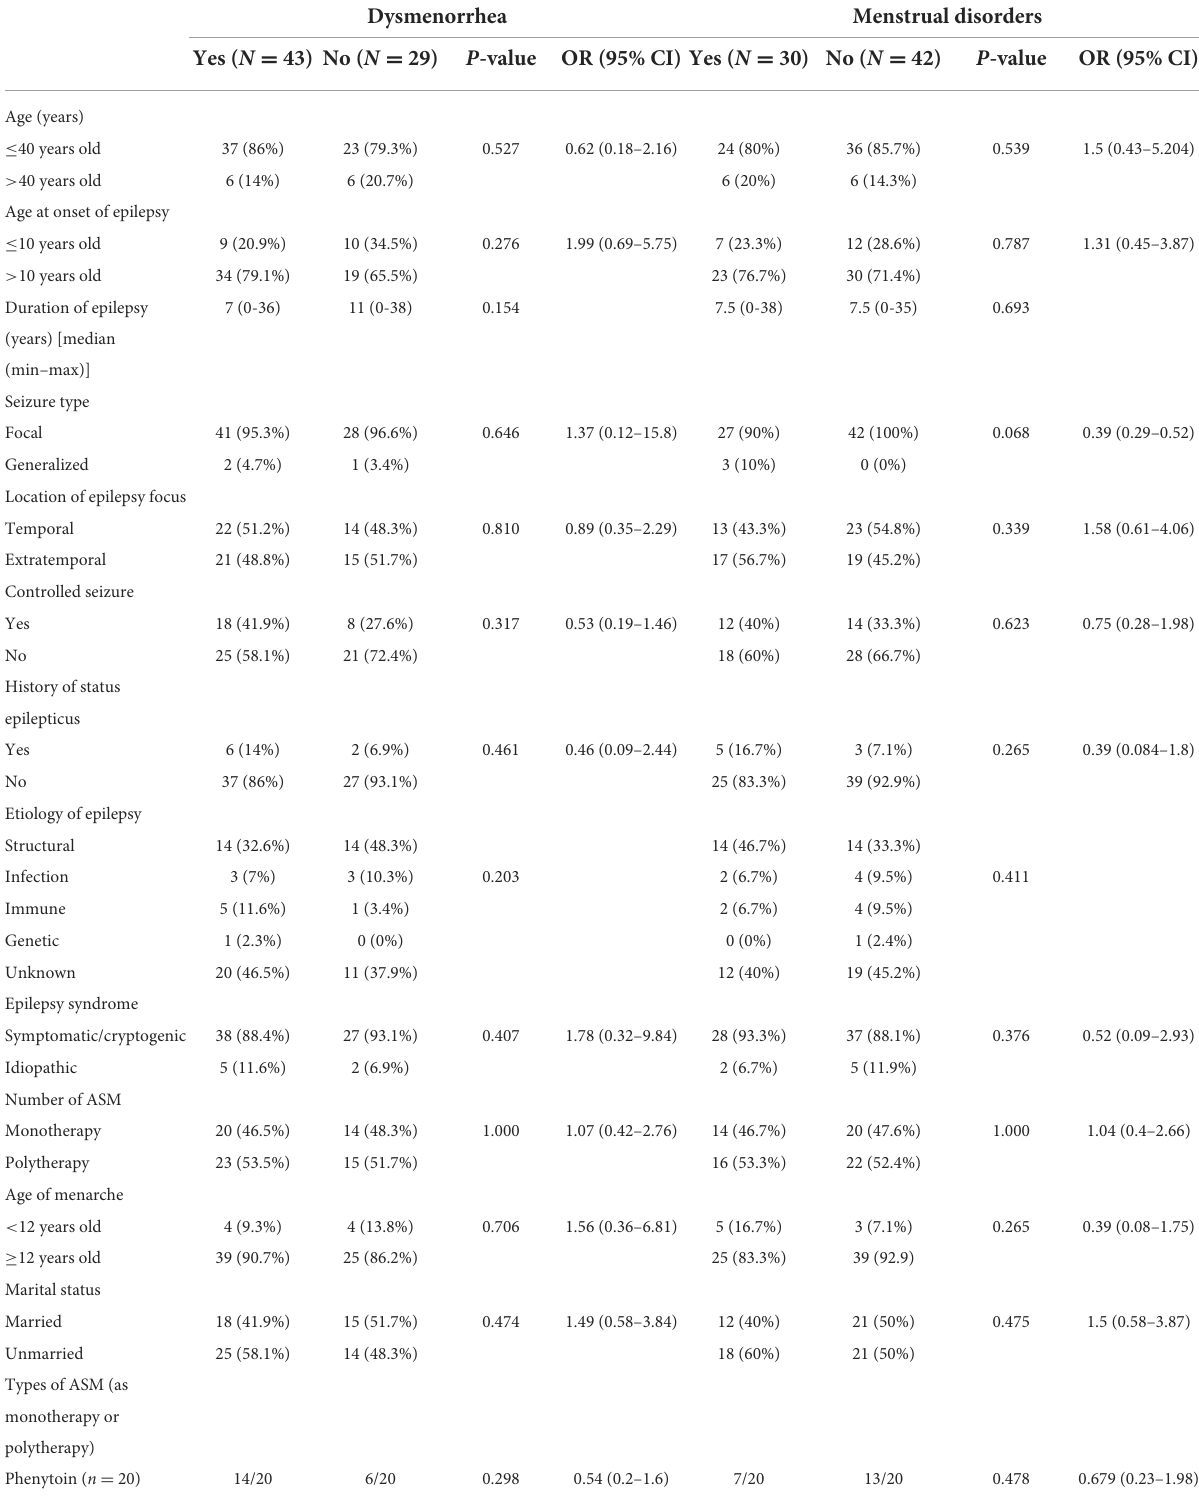
TABLE 3 Crosstabulation of dysmenorrhea and menstrual disorders in women with